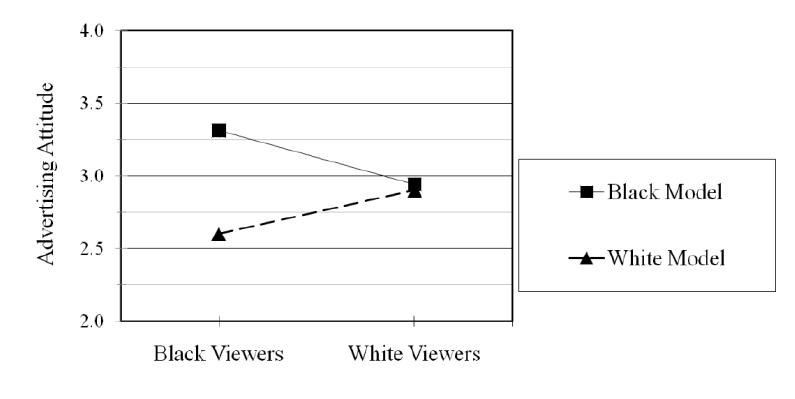
Figure 1: H 1 – Two-way interaction viewers’ racial group × Model’s racial group on advertising